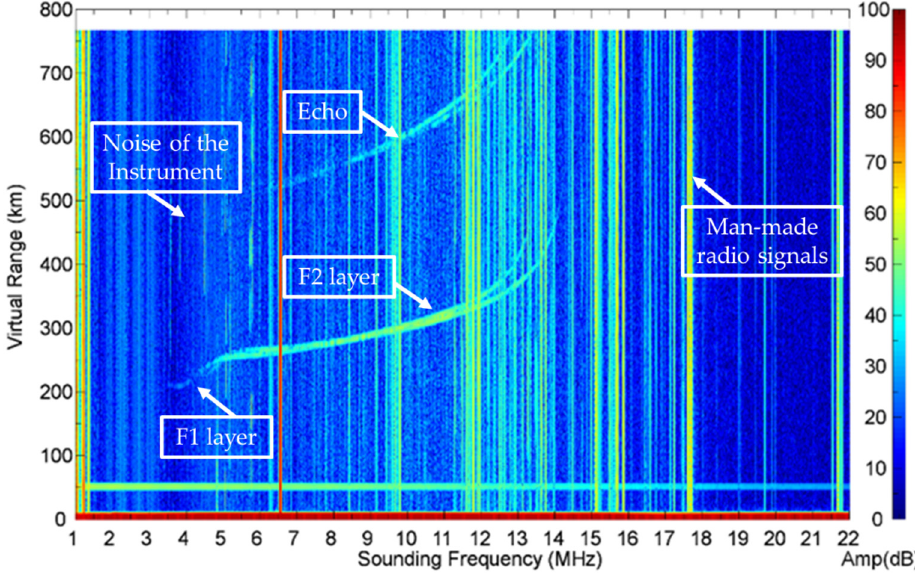
Figure 1. An example of an original ionogram. Except for during geomagnetic storm time, the useful signals usually only appear in a narrower range of frequencies and virtual heights. Therefore, to reduce the computing time, the ionograms are downsized to a frequency range from 1.58 to 20.25 MHz and virtual height range from 66 to 600 km. The resulting ionograms contain 800 pixels in frequency and 400 pixels in virtual height, as shown in Figure